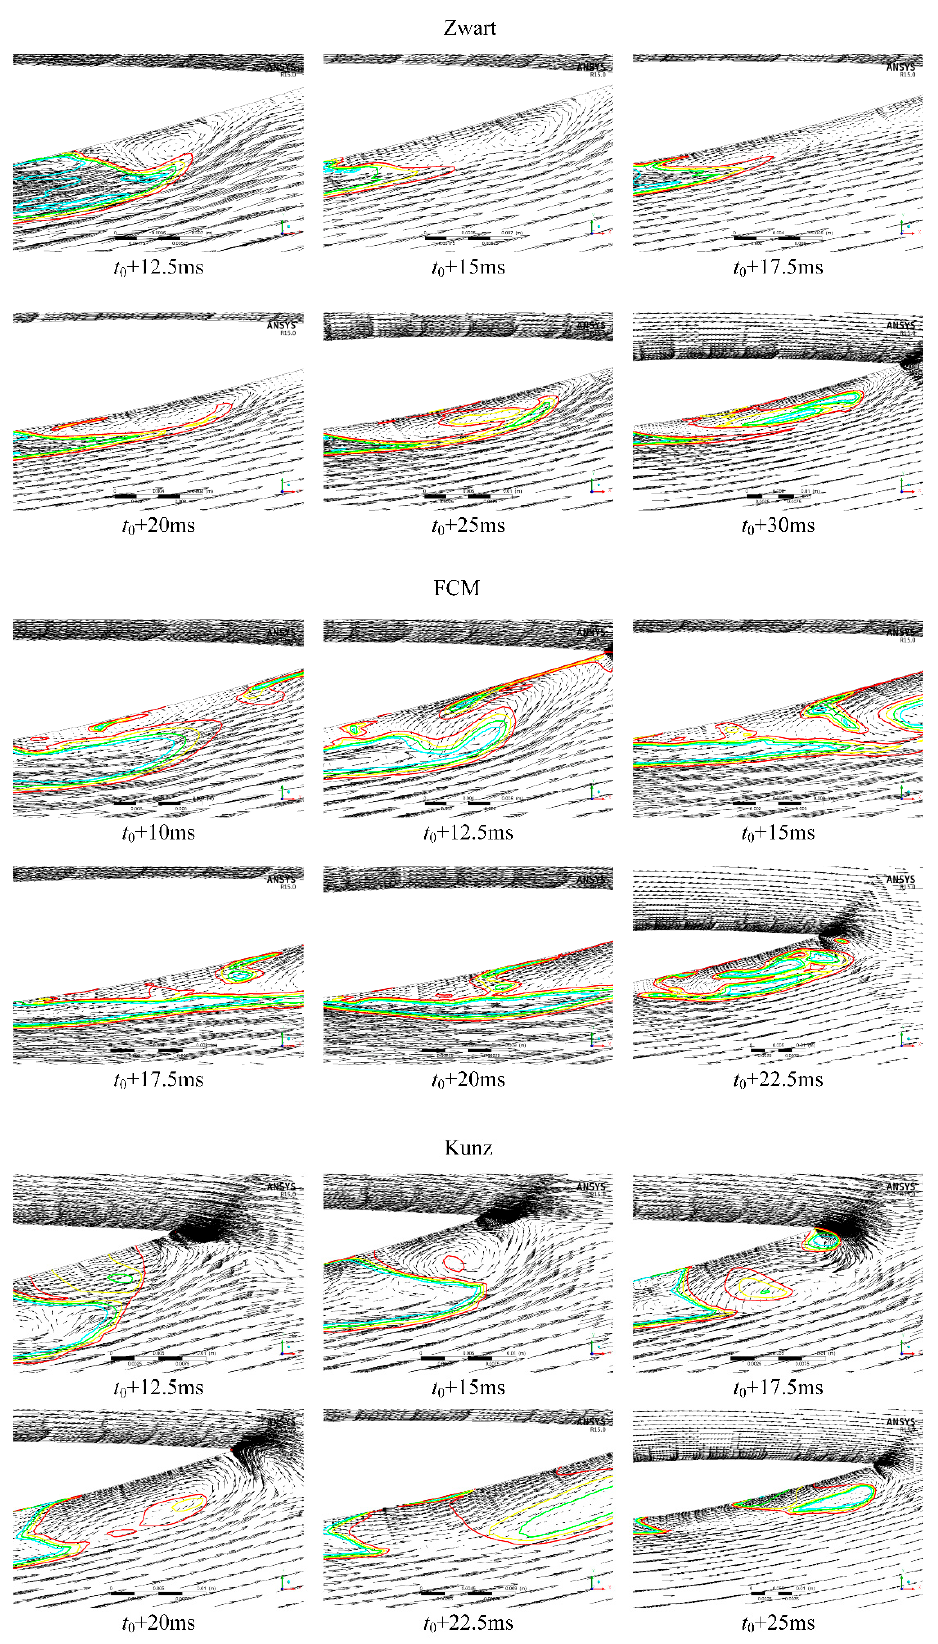
Figure 9. The formation and evolution of the re-entrant jet calculated by three different cavitation models ( σ = 0.65, α = 60°).